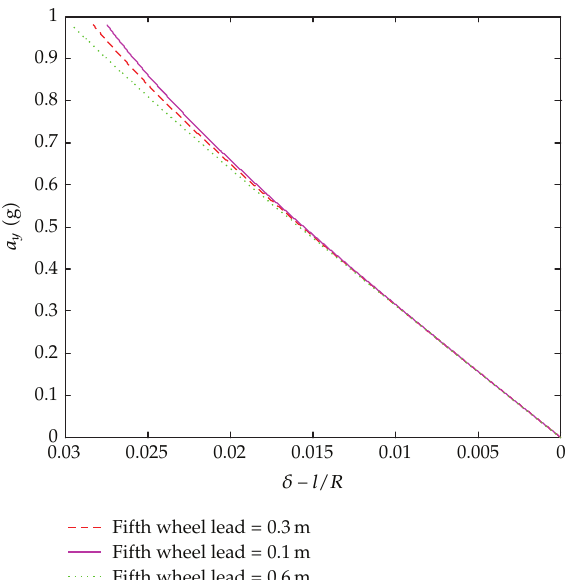
Figure 8: Handling diagram for a tractor semitrailer with two rear axles and varying fifth wheel leads.